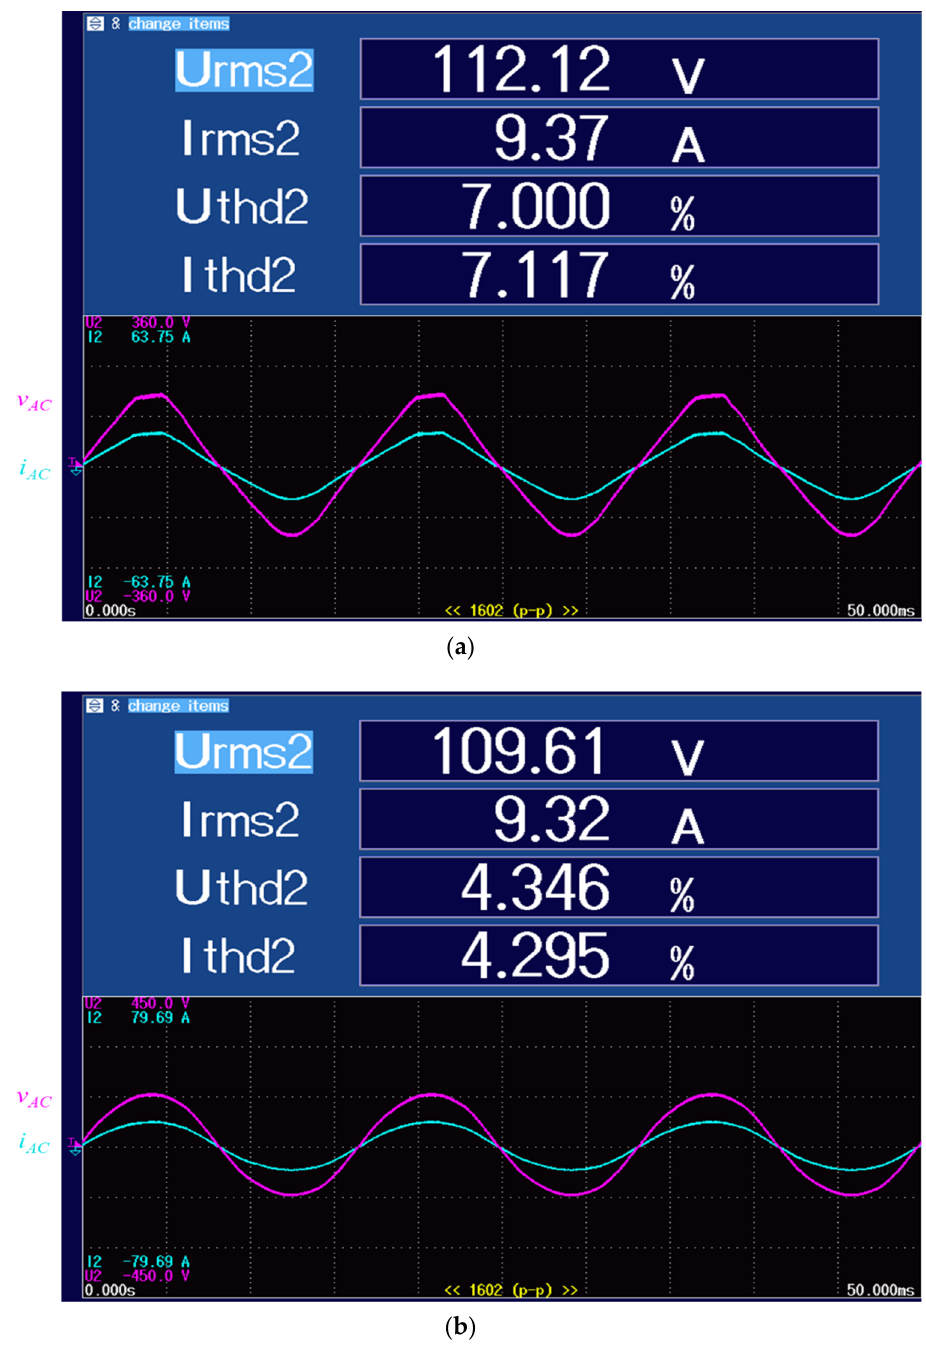
Figure 26. THD analysis in hardware experiments (1 kW) when using ( a ) the traditional SPWM control and ( b ) modified SPWM control.